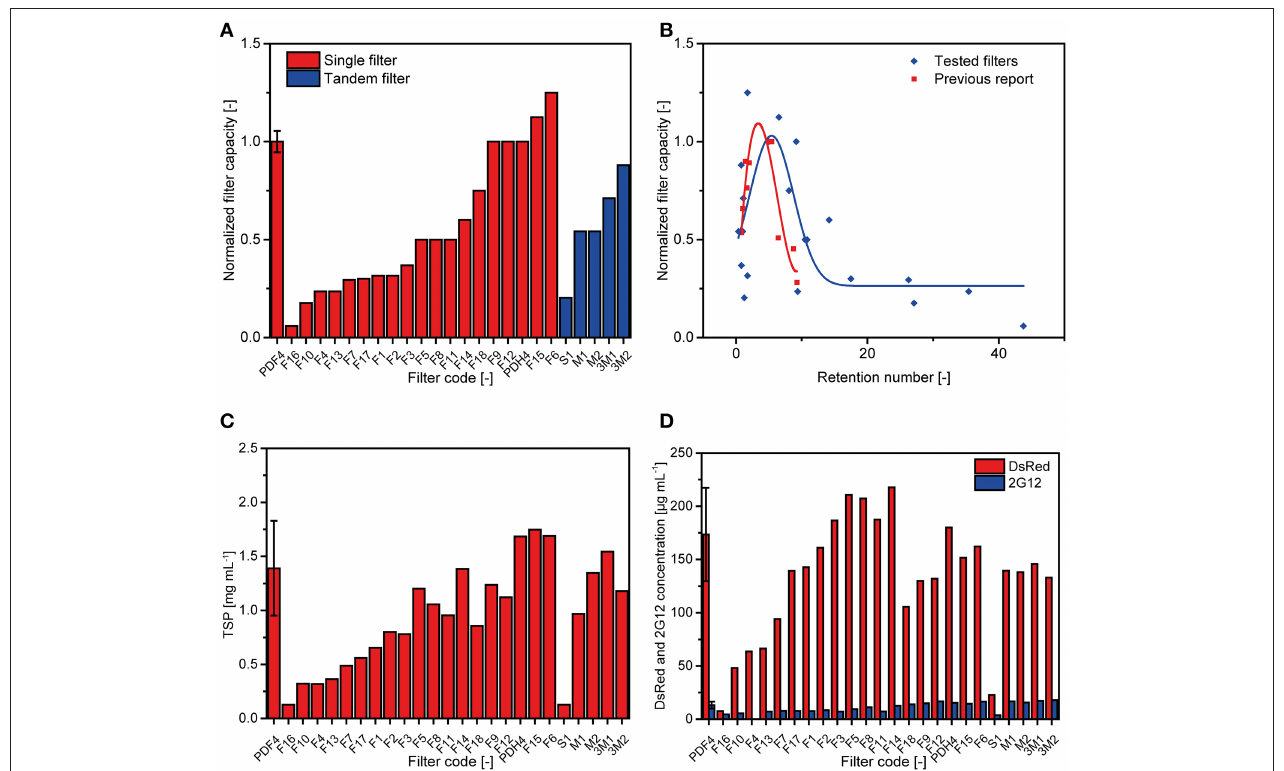
FIGURE 2 | Performance of conventional depth filters in terms of capacity and protein binding. (A) The capacity of 24 conventional depth filter setups (single filter or tandem filter) was tested in five batches and normalized to two runs of the reference filter P1 (PDF4) included in each batch ( Buyel and Fischer, 2014c). (B) Normalized capacity over RN plot showing the results for the 25 filters (including the reference) tested here (blue) compared to a previous report (red) (Buyel and Fischer, 2014c ). The maximum of a Gaussian function fitted to the data (blue line) indicates the theoretical optimum for RN and capacity. A cubic fit to the previously reported data is shown for comparison (red line). (C) TSP concentrations in the filtrates of the different filter setups as determined by the Bradford method. (D) Concentrations of DsRed and 2G12 were determined in the different filtrates by fluorescence spectroscopy and SPR spectroscopy, respectively. Error bars indicate the standard deviation of all reference runs ( n = 10